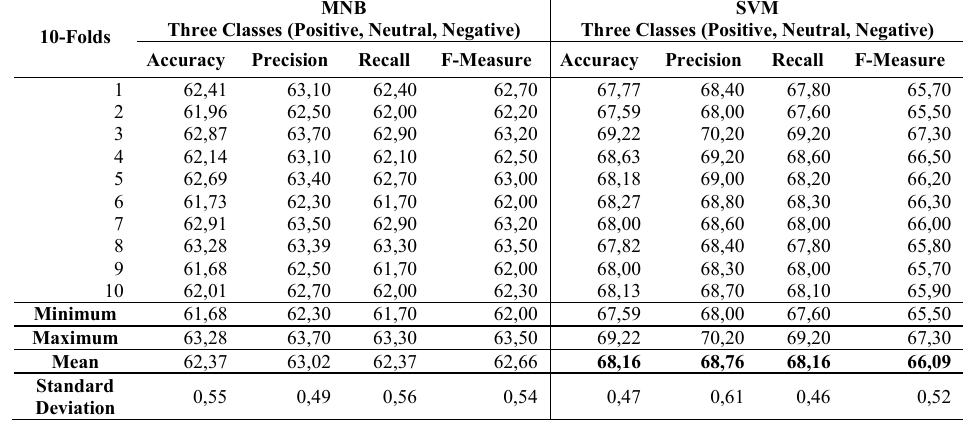
C LASSIFICATION R ESULTS OF THE G ENERAL A SPECT USING THREE CLASSES 10-Folds